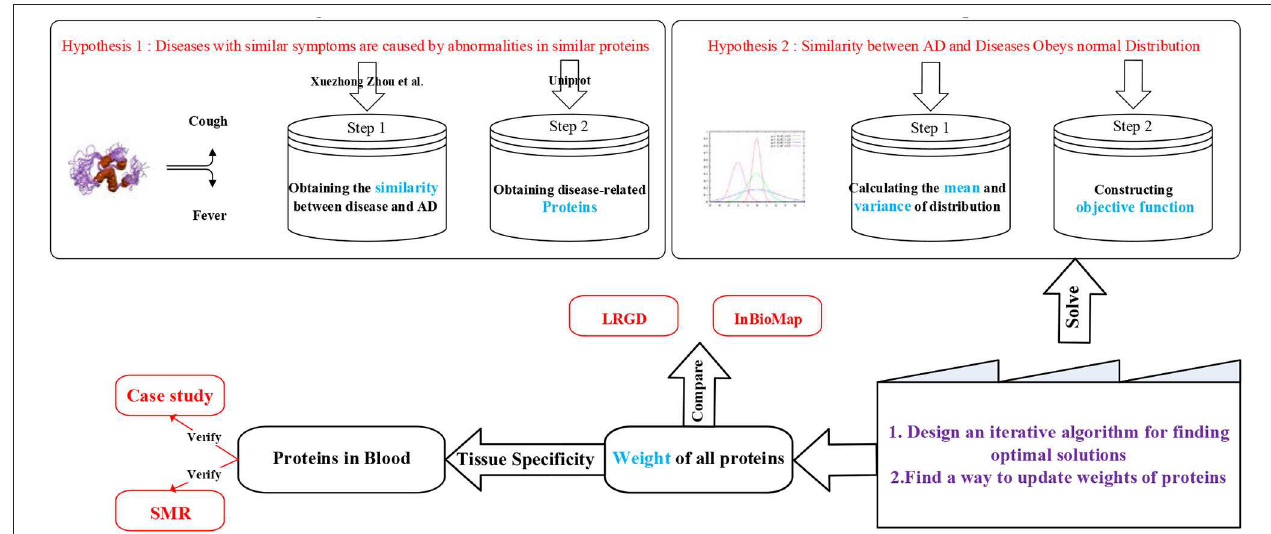
FIGURE 1 | Work frame of IBDS.